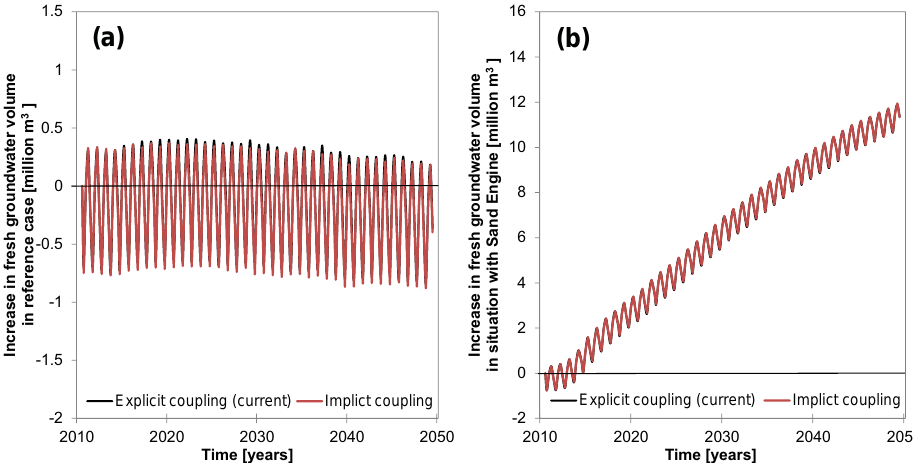
Figure A2. Increase of the volume of fresh groundwater in the situation without Sand Engine (a) and situation with Sand Engine (b) in the period 2011 to 2050, where the legend refers to the coupling of flow and transport equations.